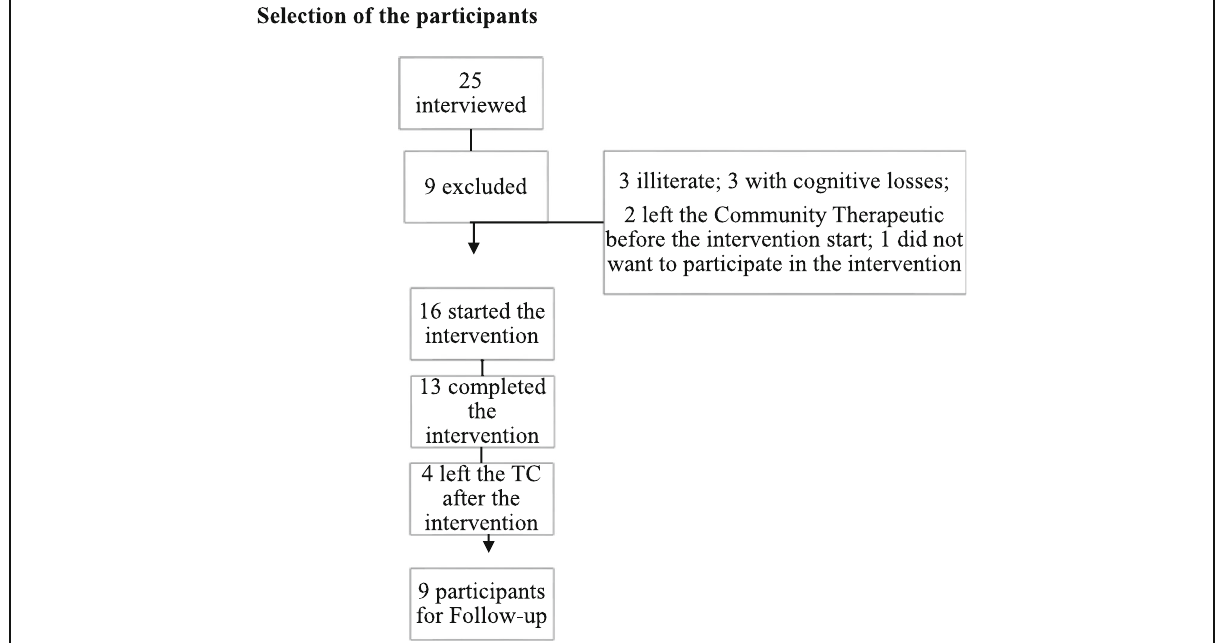
Fig. 1 Flowchart of the selection of the participants — community therapeutic. Selection of the